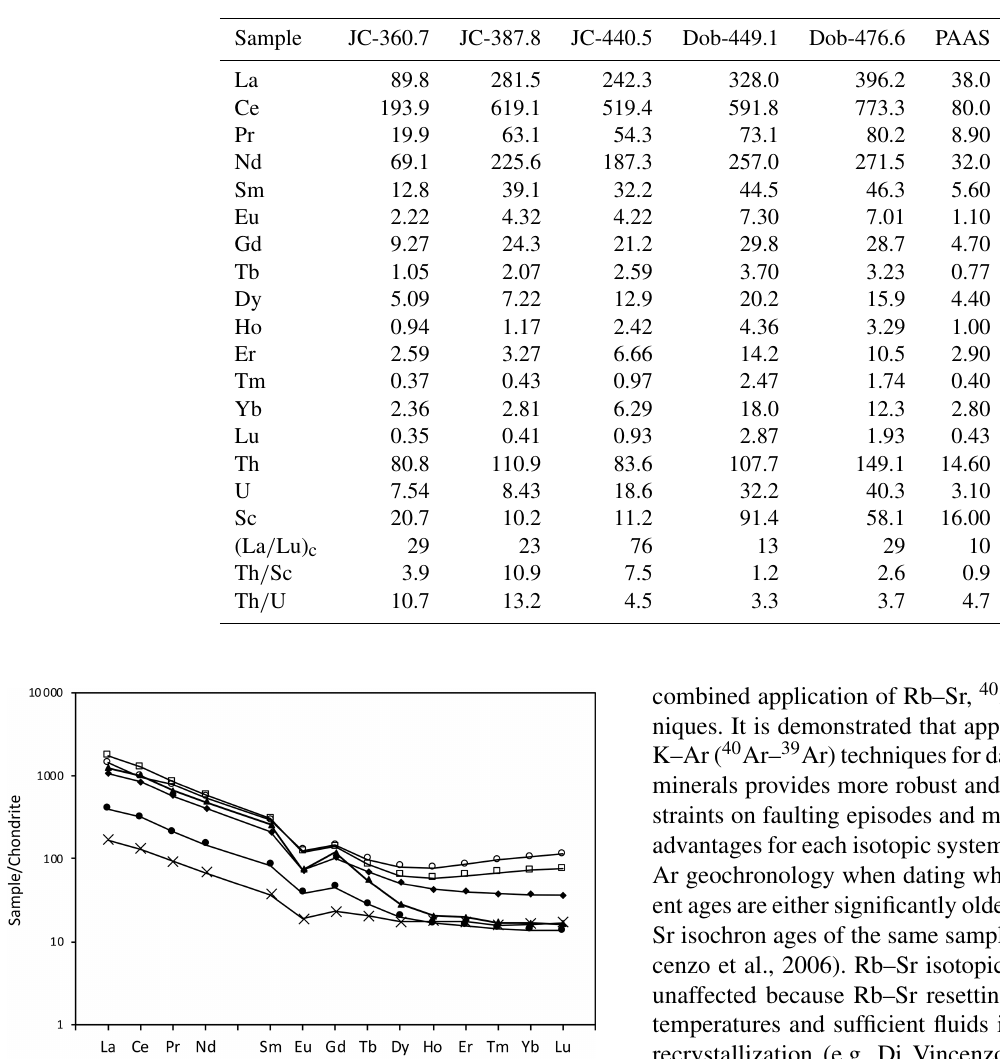
Table 4. Trace element data (ppm) for the fault gouge illites.